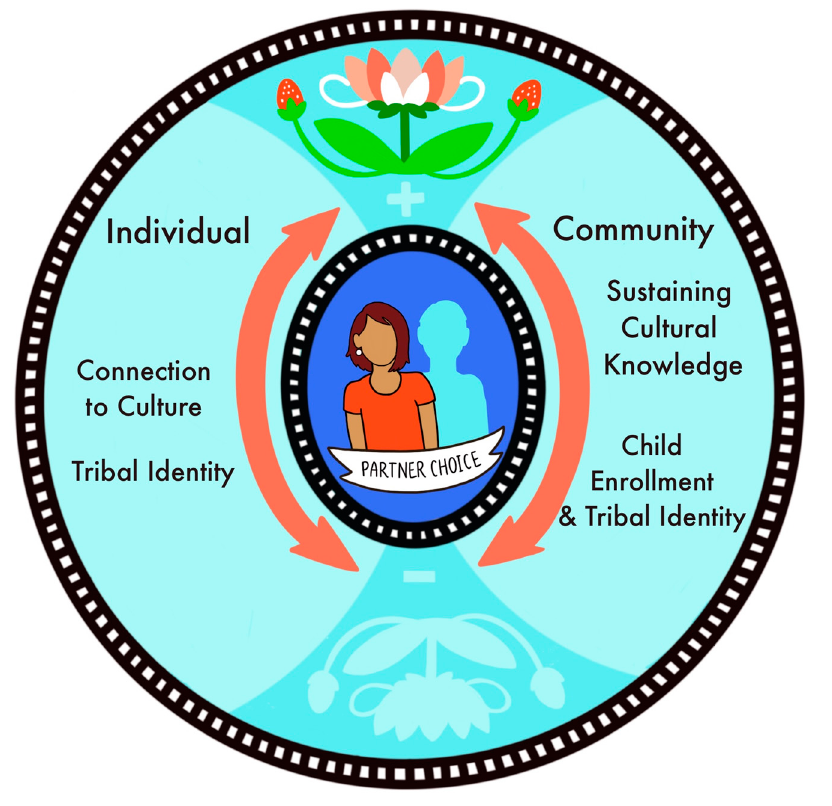
Figure 5. A young woman and a silhouette of a potential partner are at the center with surrounding text of thematic domains. See I.D. 5 in Appendix A.